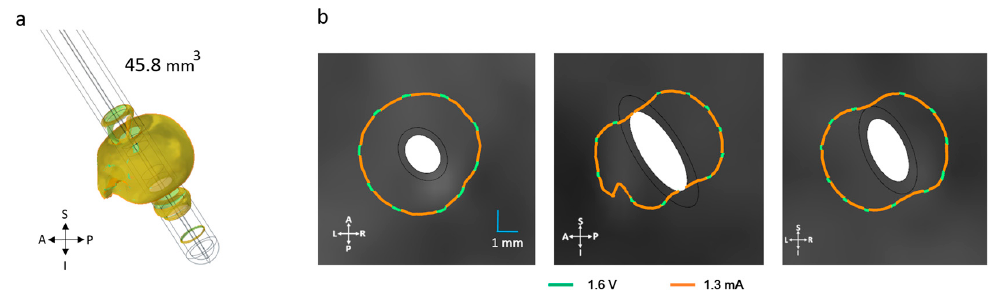
Figure 10. ( a ) Electric field (EF) distribution when the contact is set to 1.6 V and the equivalent current 1.3 mA (superimposed); ( b ) Isocontours for voltage and current superimposed. The maximal EF extent using an isolevel of 0.2 V/mm measured from the middle point of the active contact was 2.5 mm in all planes for both operating modes. A: anterior, P: posterior, S: superior, I: inferior, L: left, R: right.